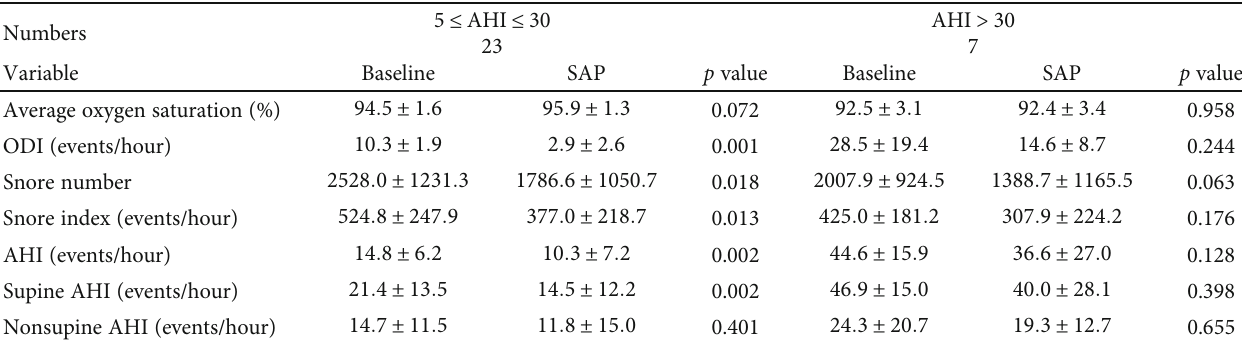
Table 3: The e ff ects of SAP in di ff erent baseline AHI severity